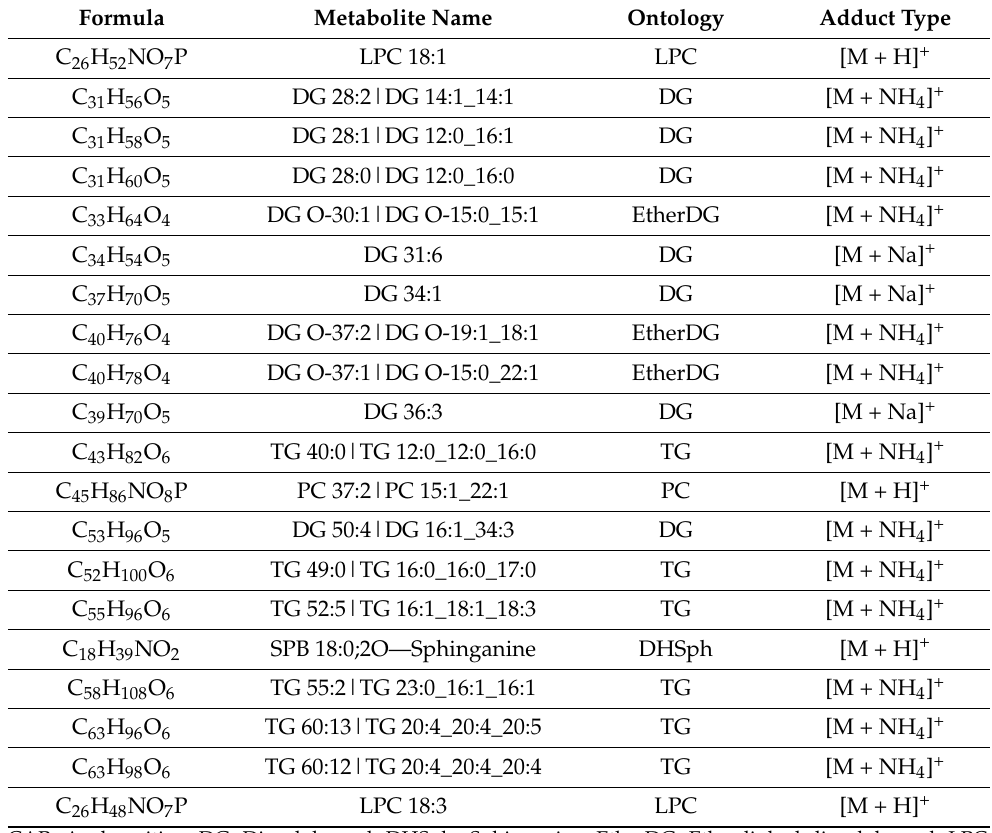
Table 3. Cutaneous lipids capable to predict the water type consumed. Formula Metabolite Name